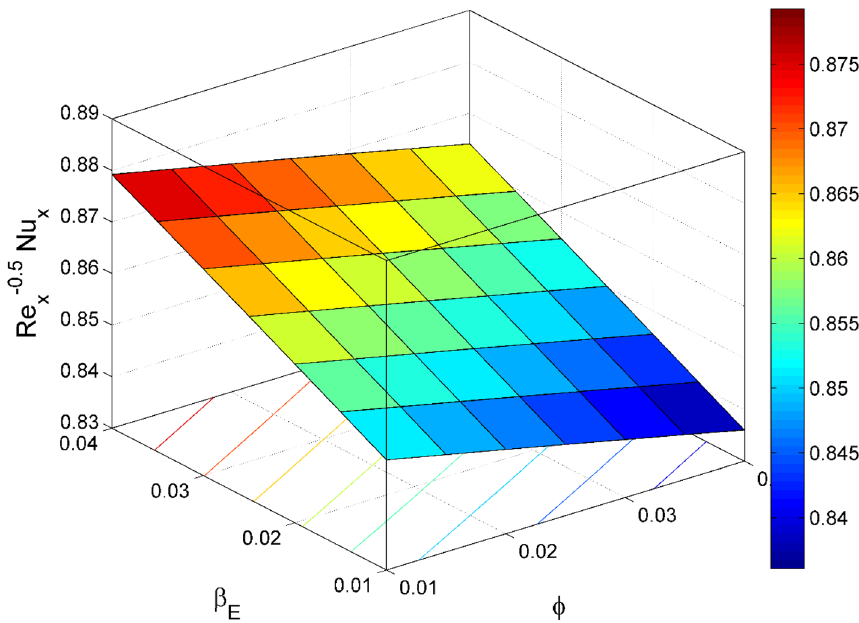
Figure 21. Re − 0.5 y Nu x behavior for the variation of heat source β E and nanoparticles volume fraction φ .